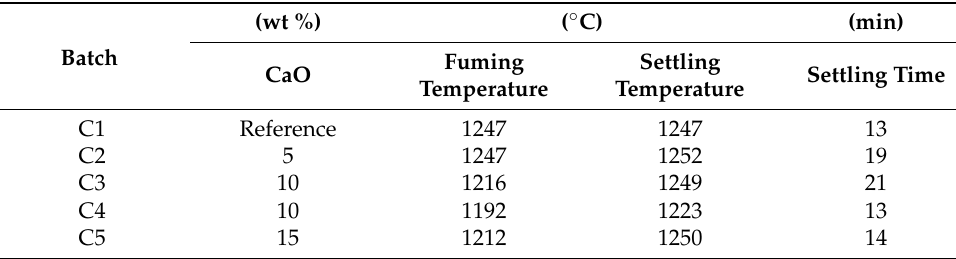
Table 1. Evaluated batches and the target CaO content, temperatures, and settling times.